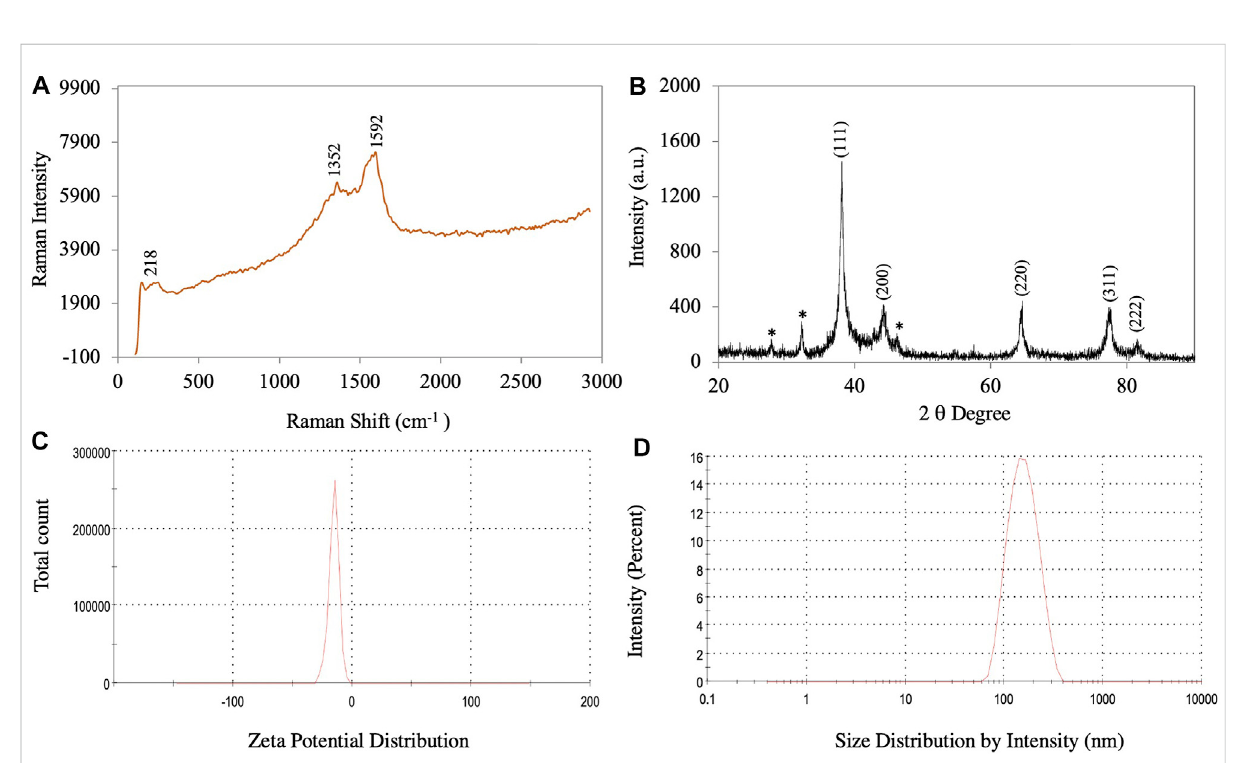
FIGURE 4 (A) Raman spectroscopy of synthesized AgNPs. (B) XRD pattern of synthesized AgNPs. (C) Zeta potential. (D) Size distribution of synthesized